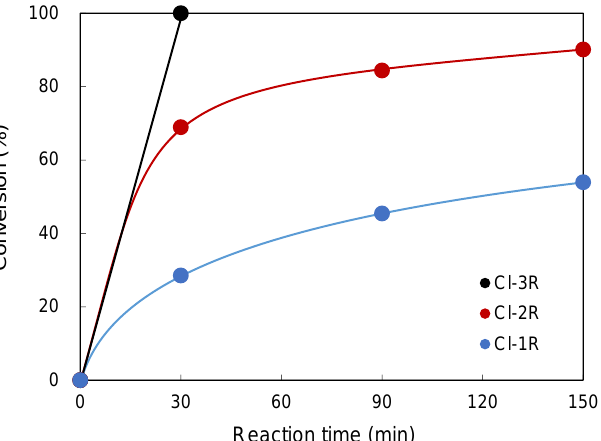
Figure 3. Time dependence of the conversion of Cl-3R (black filled circles), Cl-2R (red filled circles) and Cl-1R (blue filled circles) to corresponding BSH-modified tripeptides.